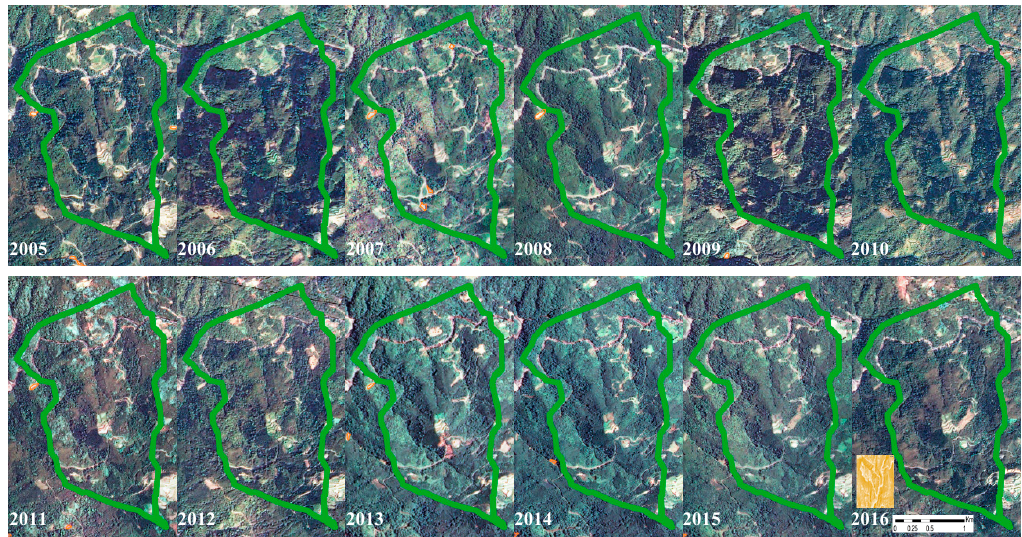
Figure 10. The annual thumbnail images overlaid with the corresponding landslide polygons in optimum sub-watersheds No. 20713, which is categorized as a low active landslide area with a level of instability of 2.